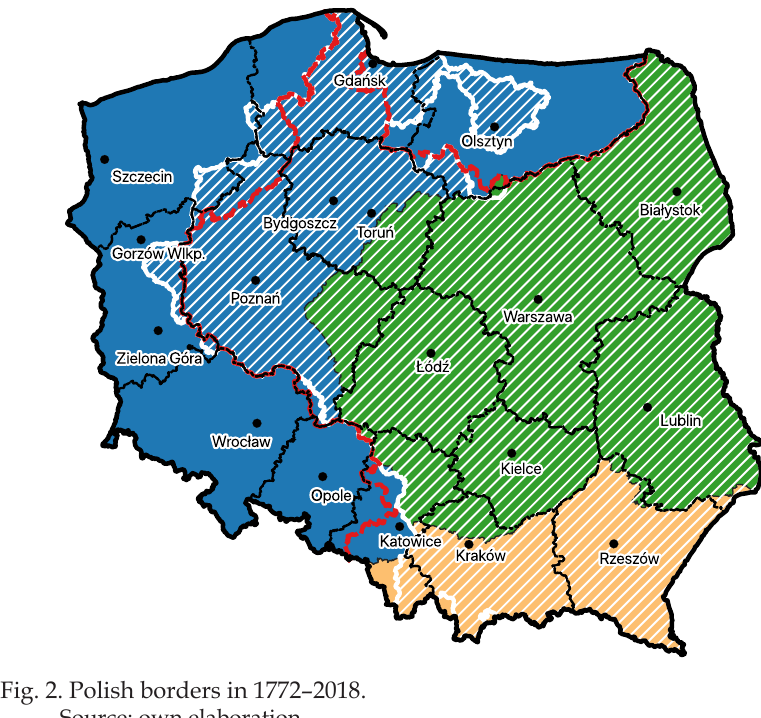
Fig. 2. Polish borders in 1772–2018. Source: own